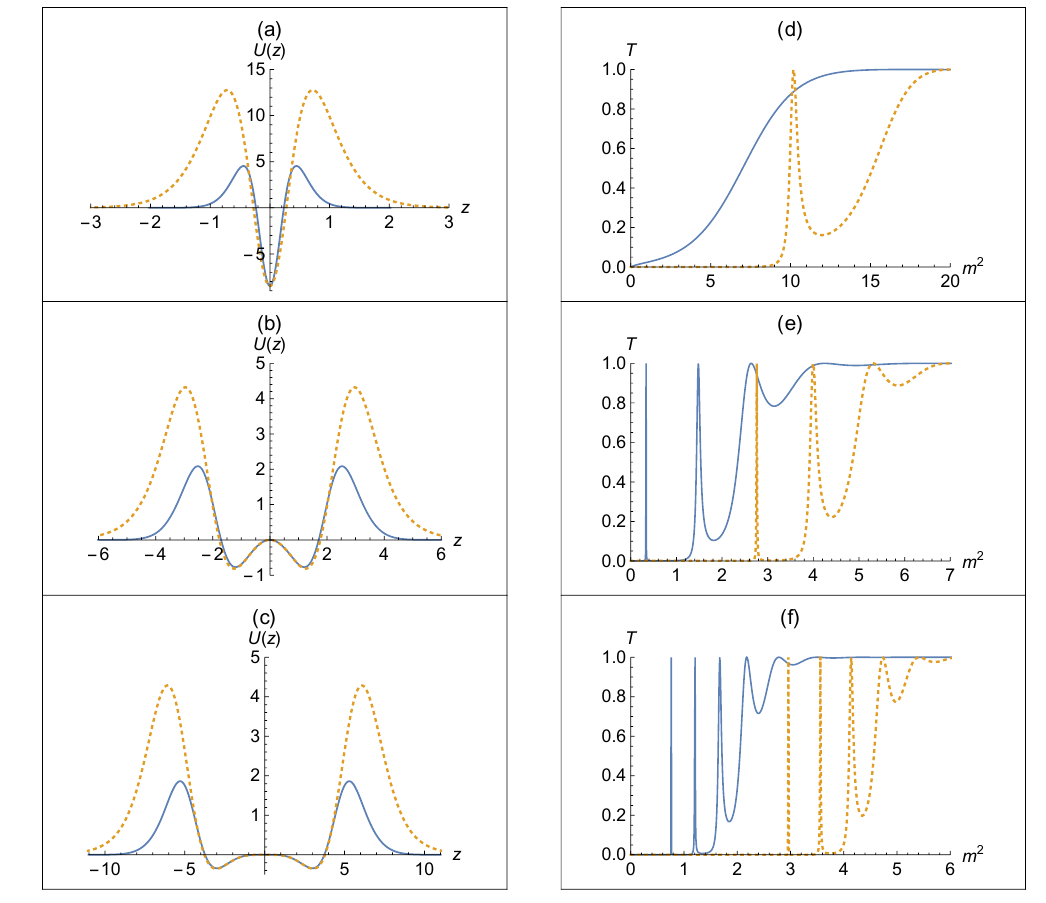
Figure 5 . Potentials U ( z ) and Transmission coe(cid:14)cient T ( m 2 ) for massive left fermions (odd dimensions) and Dirac fermions (even dimensions, choosing the function (cid:24) n (cid:0) ( x )) with (cid:21) = 1 = (2 for D = 5 (line) and D = 10 (dotted), with (cid:17) = 2 and s = 1 (a, d), s = 3 (b, e) and s = 5 (c,